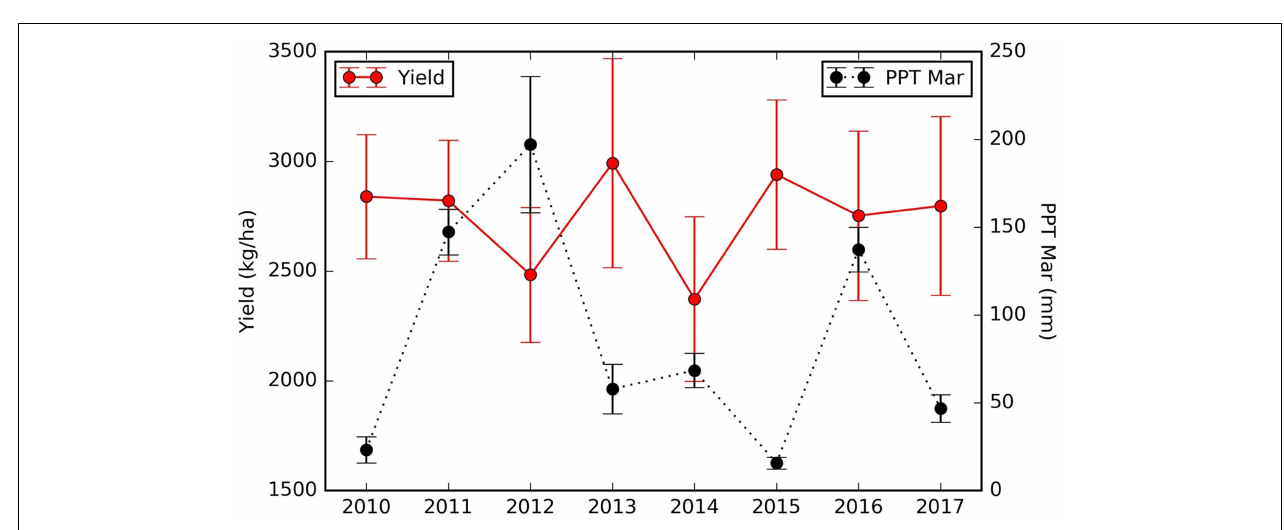
FIGURE 11 | (A) Spatial distribution of the long term mean Tmax from April to June (LT Tmax April–June); (B) locations of almond orchards in this study overlaid on top of a binary map of LT Tmax April–June with a threshold of 28.294 ◦ C; orchards with LT Tmax April–June < = 28.294 ◦ C (red cross); orchards with LT Tmax April–June > 28.294 ◦ C (blue cross); The binary long term mean April–June temperature map is shown in the background.